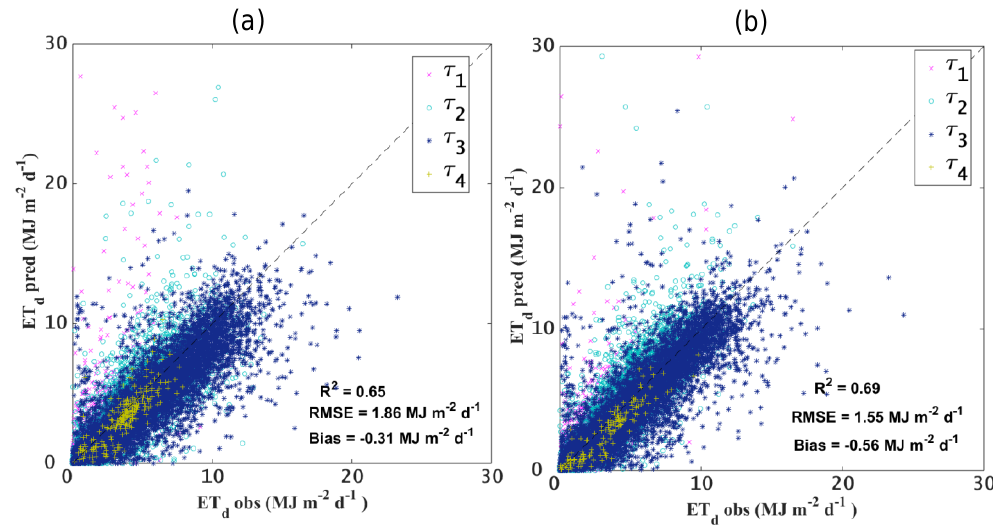
Figure 7. ET d_pred obtained through Eq. (1) vs. ET d_obs for different levels of τ from both morning (a) and afternoon (b) upscaling (11:00 and